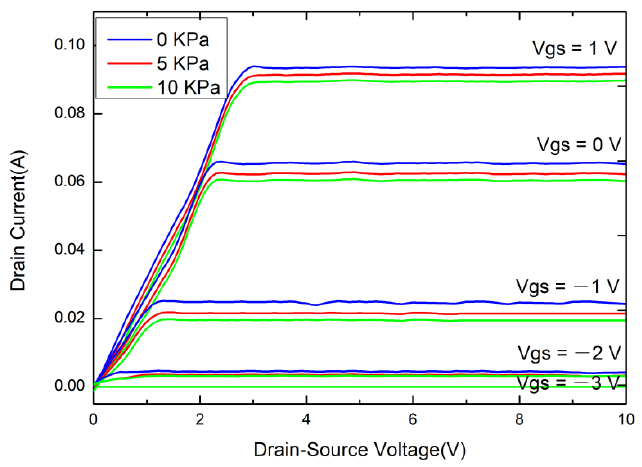
Figure 5. The output characteristic of QD-HEMT under the stress of 5 and 10 KPa.